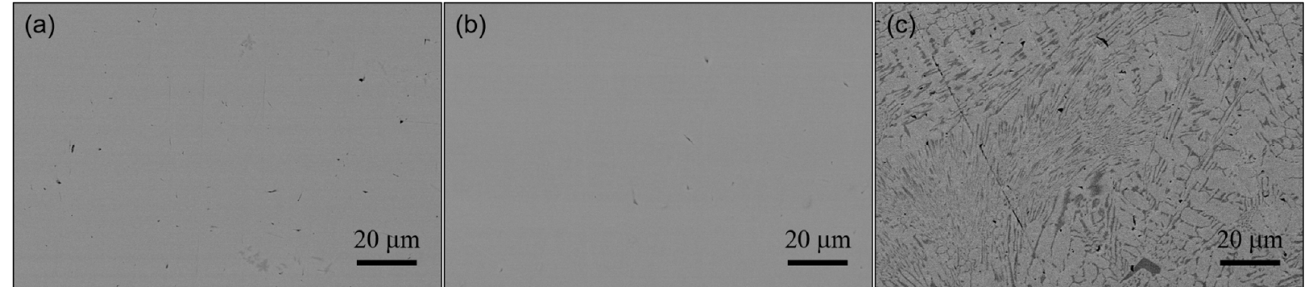
Figure 1. The SEM images of the Al 15 Zr 40 Ti 28 Nb 12 M 5 (Cr, Mo, Si) HEAs with BSE. ( a ) Cr 5 HEAs, ( b ) Mo 5 HEAs, and ( c ) Si 5 HEAs.